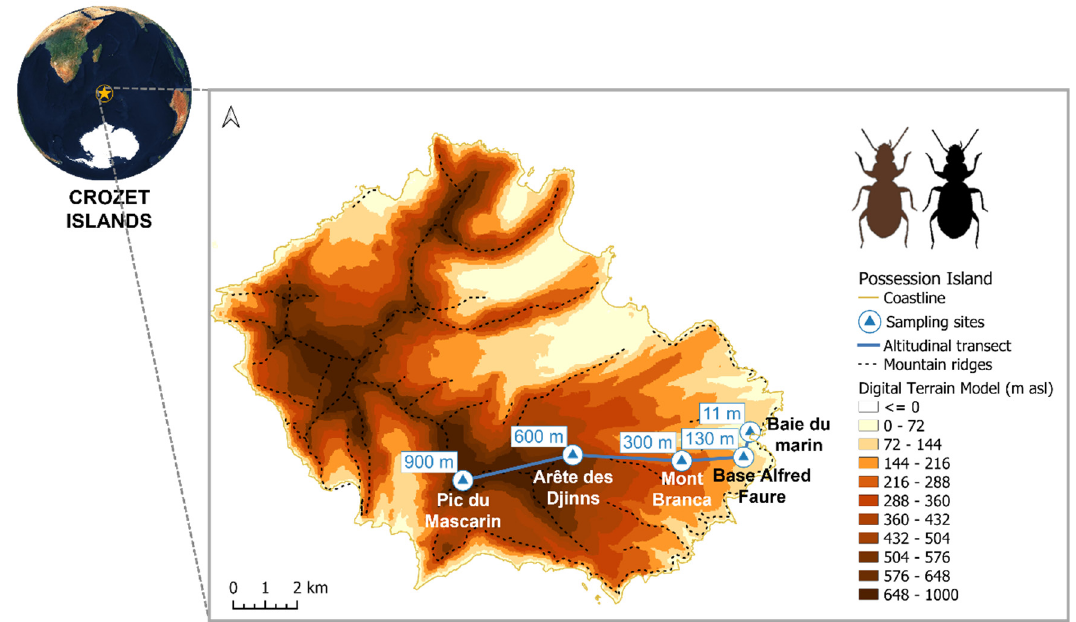
Figure 1. Location of Crozet Islands and description of the altitudinal transect (blue line) conducted on Possession Island (Crozet Islands). The altitudinal transect was set up from 11 m to 900 m above sea level (asl). It included five collection sites: (1) Baie du Marin at 11 m, (2) Base Alfred Faure at 130 m, (3) Mont Branca at 300 m, (4) Arête des Djinns at 600 m, and (5) Pic du Mascarin at 900 m (5). The digital elevation model was derived from a Shuttle Radar Topography Mission satellite image with a spatial resolution of 30 m, and allowed obtaining a digital terrain model.